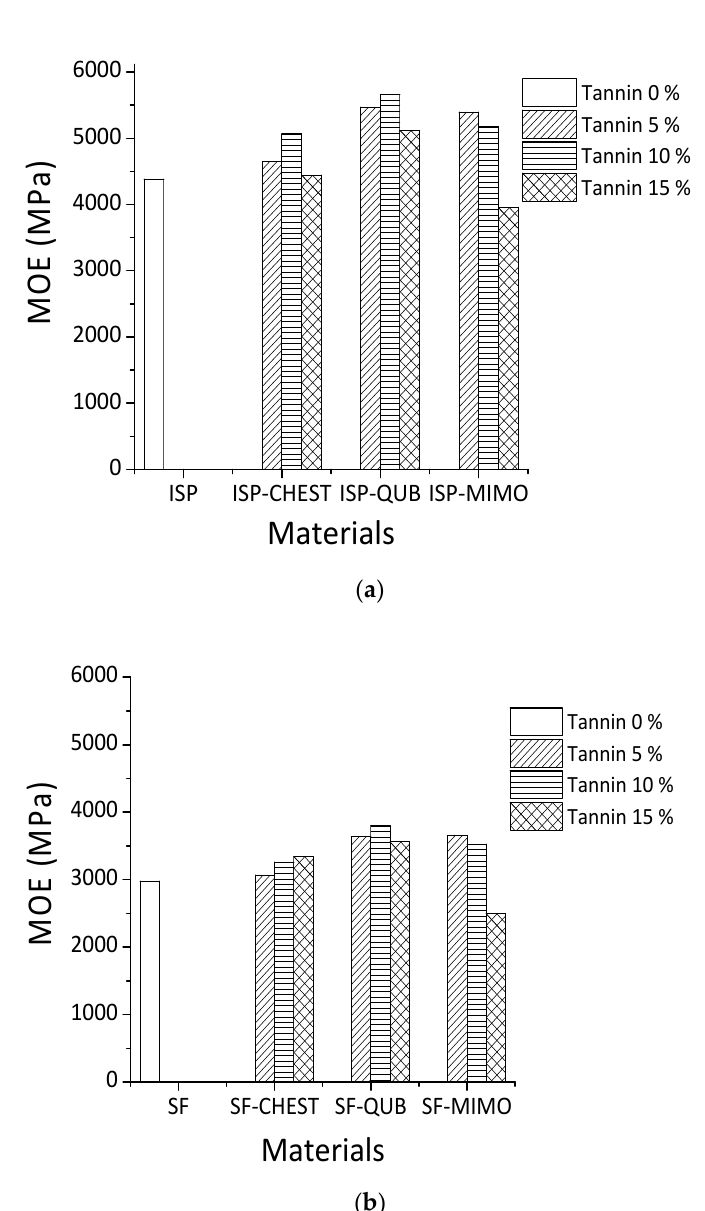
Figure 3. Effect of different tannins extracts on MOE of ISP ( a ) and SF ( b ). Based on the results obtained from MALDI-TOF mass spectrometry, covalent and ionic bonds can form between soy amino acids and tannins (Figure 3). For these reasons, the MOE of tannin-modified soy flour adhesive is increased. In previous studies on tannin and protein interactions, different bonds such as hydrogen, covalent, ionic and hydrophobic bonding between tannin and protein were reported [21,42,43], and the reaction between tannins and ammines has been recently studied and codified in depth [44]. Condensed polyflavonoid quebracho and mimosa tannins when compared to hydrolysable chestnut tannin showed better reaction with soy protein. This happened because of the higher reactivity of aromatic -OH groups in condensed tannins than the aromatic and aliphatic -OH groups in hydrolysable tannins. Between two industrial polyflavonoids, quebracho appears to react well with soy protein. Compared to the more branched structure of mimosa tannin oligomers, quebracho tannin oligomers are predominantly linear and the inter flavonoid link in quebracho tannin structure is more easily hydrolysable. These